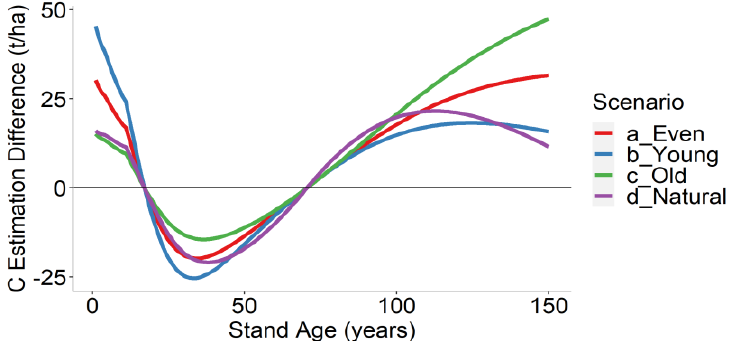
Figure 11. Absolute difference between CBM and PSP methods (CBM-PSP) for the landscape carbon estimation in the case of four scenarios: (a) even stand ages across the landscape; (b) young-skewed; (c) old-skewed; (d) natural age distribution.